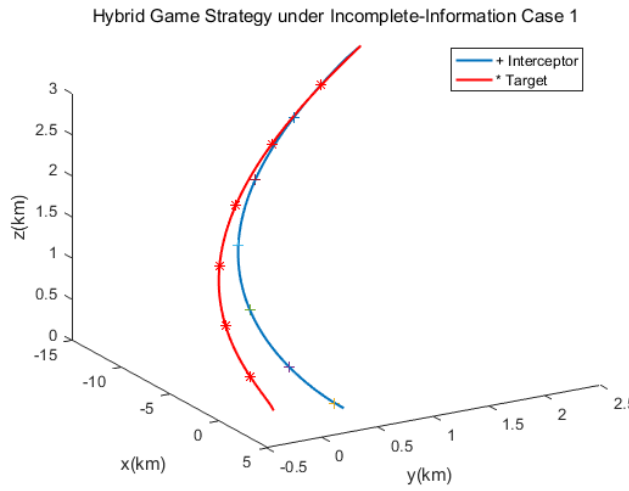
Figure 3. Spacecraft trajectories of the hybrid game strategy.